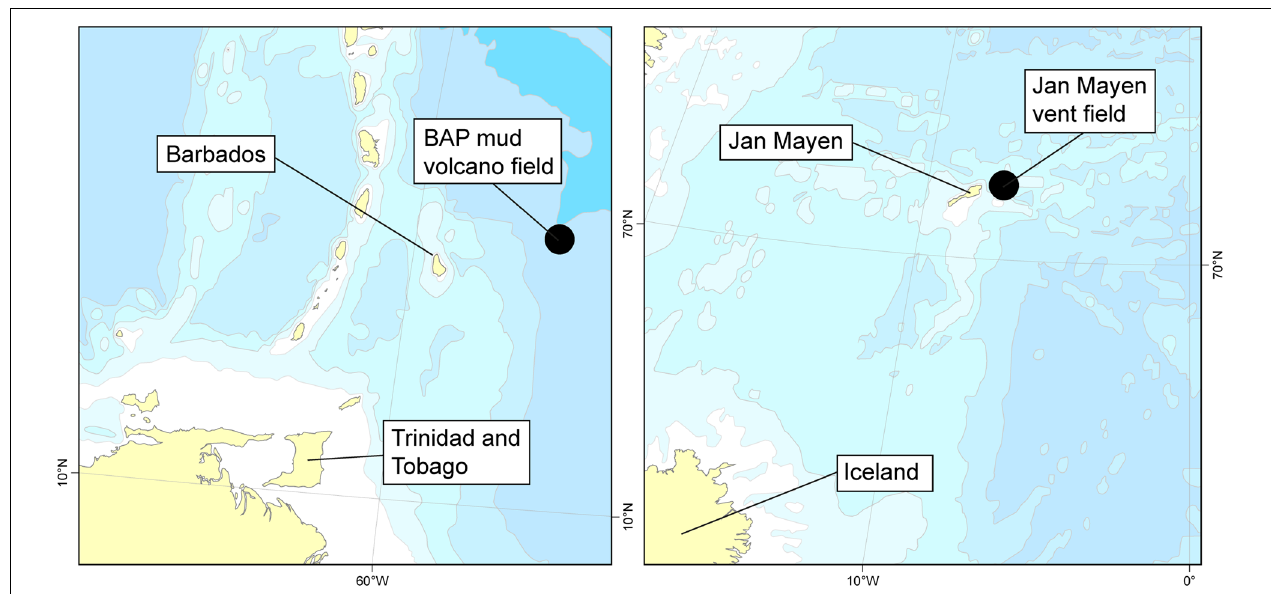
FIGURE 1 | Collection of samples included in this study. Left: Diapiric field at the base of the Barbados Accretionary Field (BAP). Right: Jan Mayen Vent Field on the southwestern Mohns Ridge, part of the Arctic Mid-Ocean